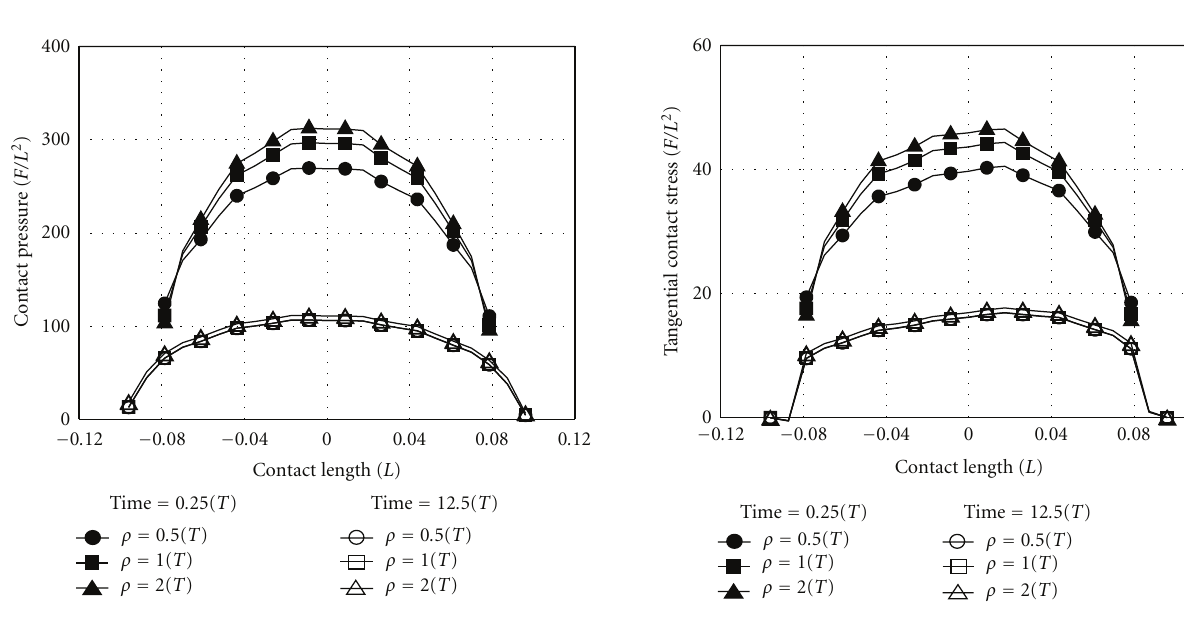
material relaxation time ρ . E ff ects of these parameters on the contact configuration as contact stresses distribution, extent of the contact area, relaxation of the contact stresses, and relative tangential displacements throughout the contact interface are completely detected. E ff ects of the material characteristics of viscoelastic layers on the contact status can be summarized as